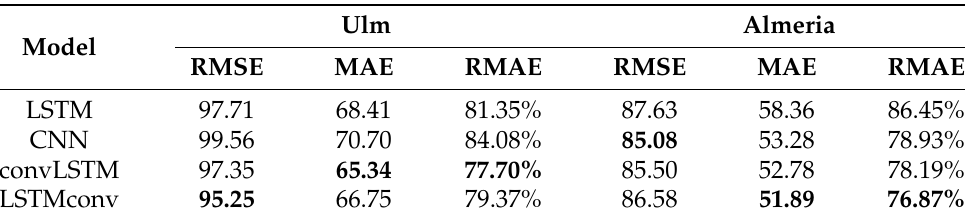
Table 4. Performance results of the different NN Models for the cities Ulm and Almeria. The best results marked in bold